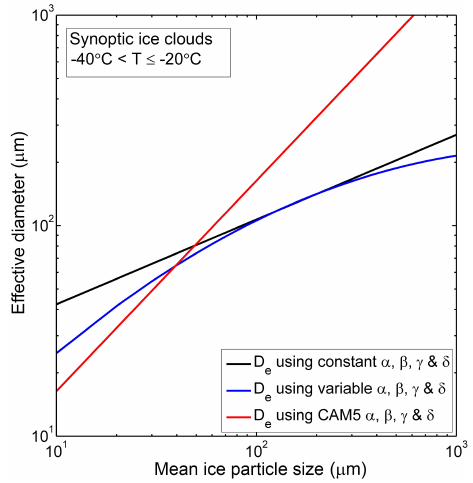
Figure 12. Dependence of the ice particle N on D using the four methods indicated for determining α and β . The black and blue curves use the m - D curve fit based on Table 1 for the indi- cated temperature range, with the black curve α and β evaluated at D = 500µm.